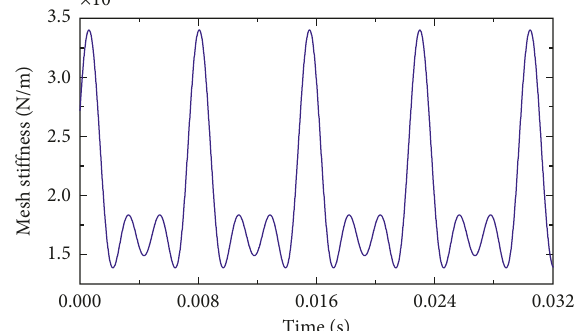
Figure 12: Mesh stiffness of gear 3 and gear 4.